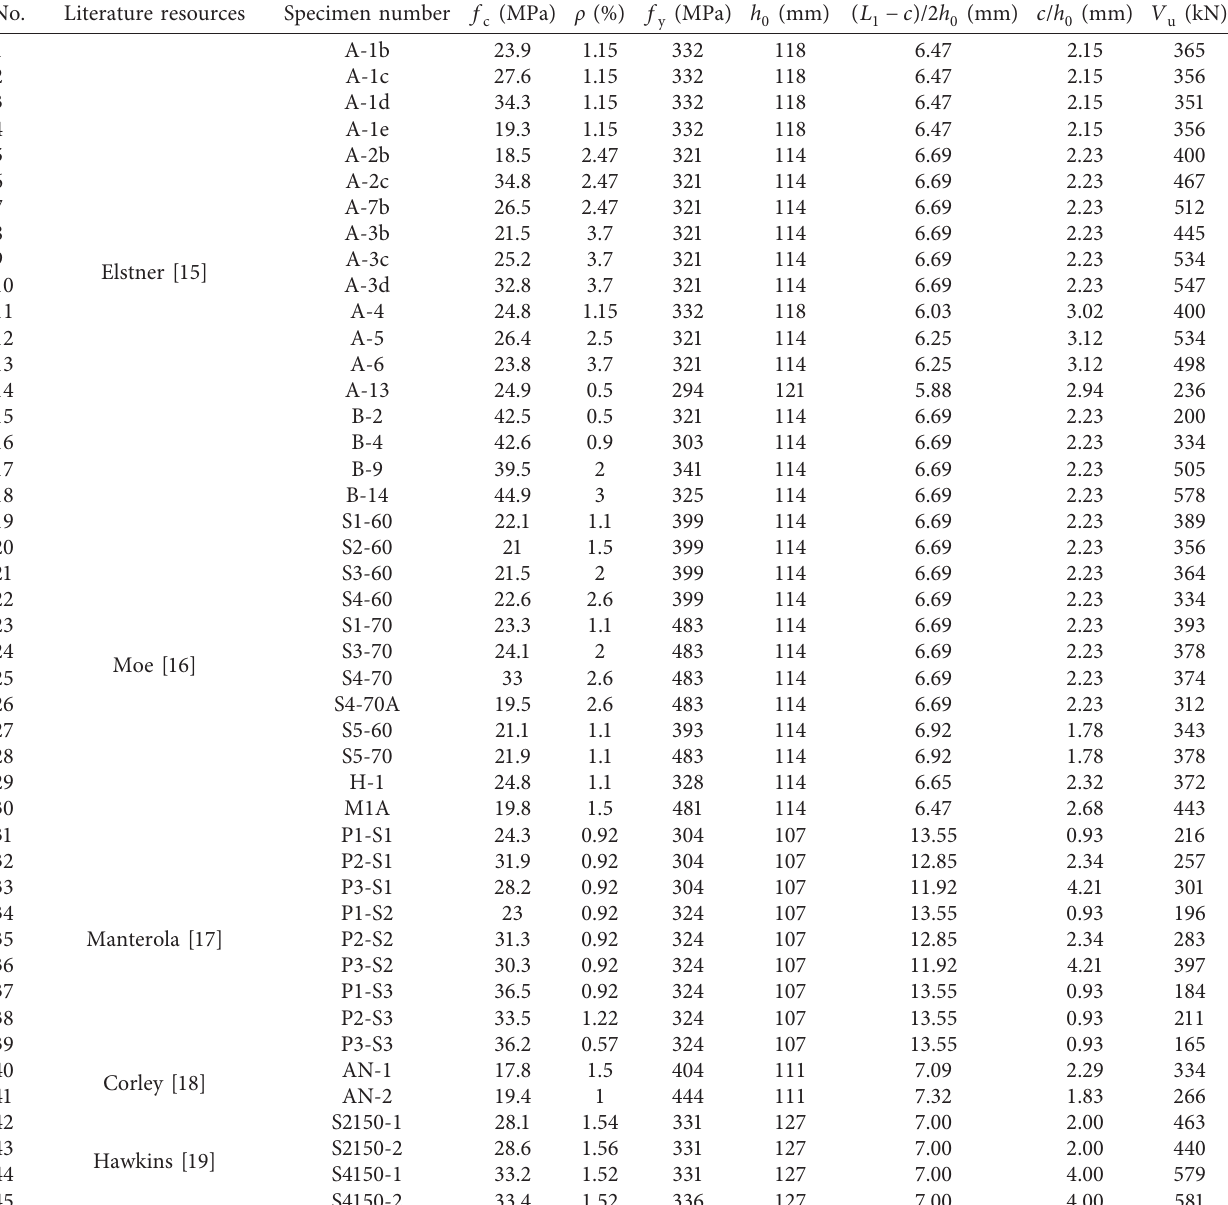
Table. 1: The data of slab-column connections are provided in Table.